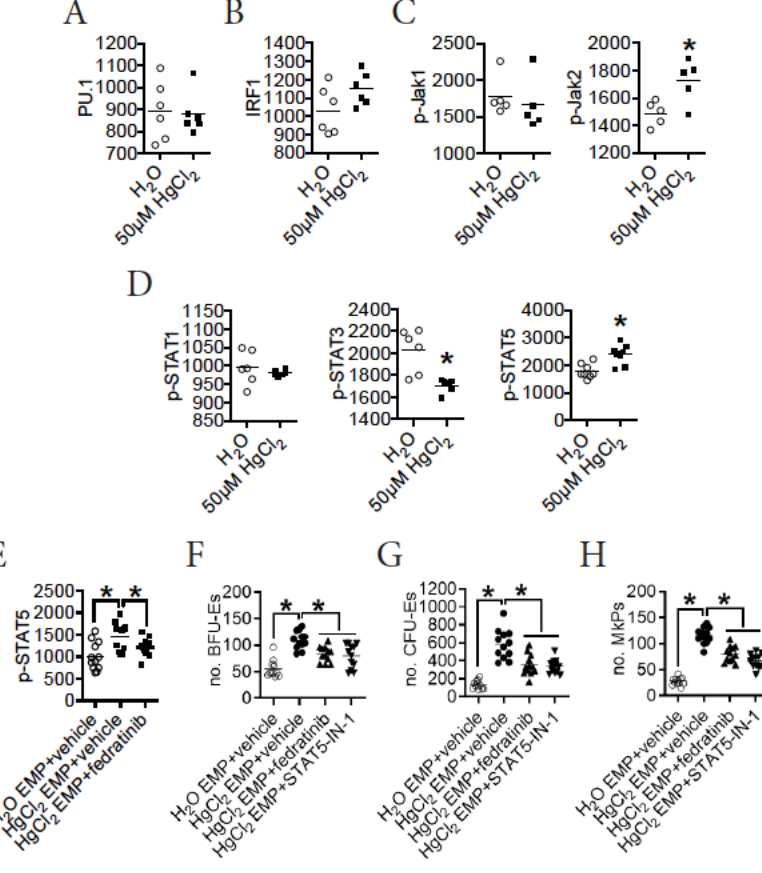
Figure 4. HgCl 2 activates the Jak2/STAT5 pathway to promote the differentiation of EMPs in B10.S mice. B10.S mice were treated with the control or 50 µ M HgCl 2 for 4 w, and multiple signaling molecules involved in erythropoiesis including PU.1, IRF1, p-Jak1, p-Jak2, p-STAT1, p-STAT3, and p-STAT5 were measured for EMPs in the BM thereafter; FACS-purified EMPs from the BM were treated in the presence or absence of inhibitors for the Jak2/STAT5 signaling pathway in vitro for 16 h to evaluate its impact on STAT5 signaling and EMP differentiation into BFU-Es, CFU-Es, and MkPs. ( A ) The expression of PU.1 (mean fluoresce intensity, MFI) in EMPs in the BM. ( B ) The expression of IRF1 (MFI) in EMPs in the BM. ( C ) The expression of p-Jak1 and p-Jak2 (MFI) in EMPs in the BM. ( D ) The expression of p-STAT1, p-STAT3, and p-STAT5 (MFI) in EMPs in the BM. ( E ) The expression of p-STAT5 (MFI) in EMPs in the presence or absence of Jak2 inhibitor (fedratinib) in vitro. ( F ) The number of BFU-Es in the in vitro assay. ( G ) The number of CFU-Es in the in vitro assay. ( H ) The number of MkPs in the in vitro assay. Each dot represents one mouse or one sample, and a total of 5 to 12 mice were used for each group. Asterisk indicates a significant difference compared to the counterpart control group. p < 0.05 was considered as the level of significant dif- ference.